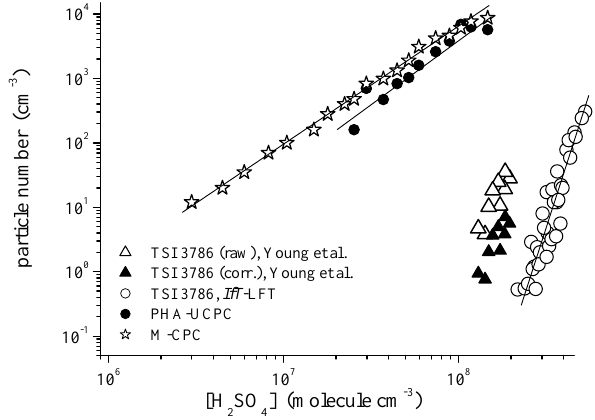
Fig. 6. Measured particle numbers as a function of end-[H 2 SO 4 ] at 288K (cf. Figs. 9 and 10 in Young et al., 2008) and as a function of average-[H 2 SO 4 ] at 293K from this study ( IfT -LFT); RH=15%. Measurements have been done by means of H 2 O-based UCPC (TSI 3786), PHA-UCPC and M-CPC. UCPC (TSI 3786) used in the IfT - LFT experiments operated at the default temperature settings, time for number averaging: 60–300s. The residence time was 19s in the Young et al. (2008) experiments. The IfT -LFT was operated with a residence time of 19.3s in the irradiated middle section (25.2s for middle + end section). For explanation of the corrections done by Young et al. (2008) see the original